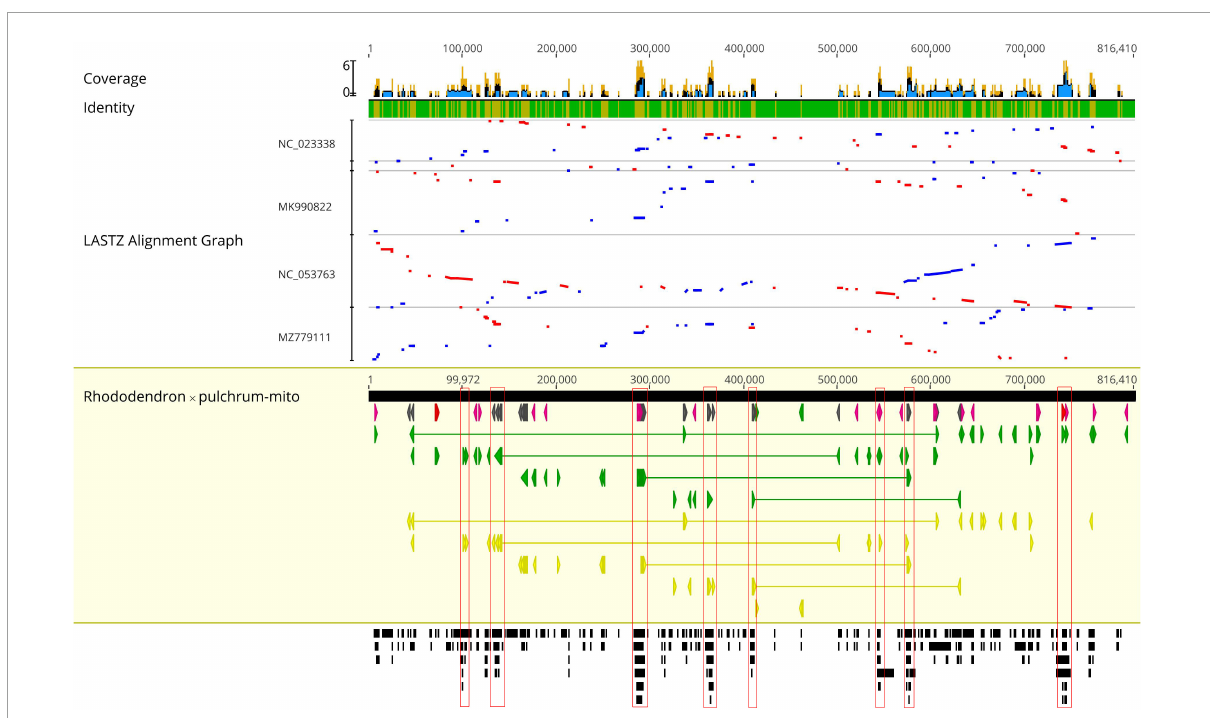
FIGURE3 Complete mitochondrial genome collinear alignment compared between five species from the Ericaceae family. ( Rhododendron × pulchrum as the reference; blue bars represent homologous high-scoring segment pairs in a codirectional orientation, whereas red bars represent reversed pairs. Yellow arrows represent coding sequences, red arrows represent ribosomal RNA genes, purple arrows represent transfer RNA genes, green arrows represent protein-coding genes, and gray arrows represent exonic regions. Black squares represent homology; the larger the number, the larger the area of the black squares, and the more closely related species have homologous fragments. Red wireframes are the most conservative regions. These regions, marked from left to right in the figure, are distributed from left to right and contain the following genes: atp4 and ccmC ; nad4 ; trnC-GCA , trnN-GUU , trnY-GUA , and nad2 ; nad4 ; nad5 ; trnM-CAU and trnD-GUC ; nad2 ; rrn26, and trnM-CAU ).